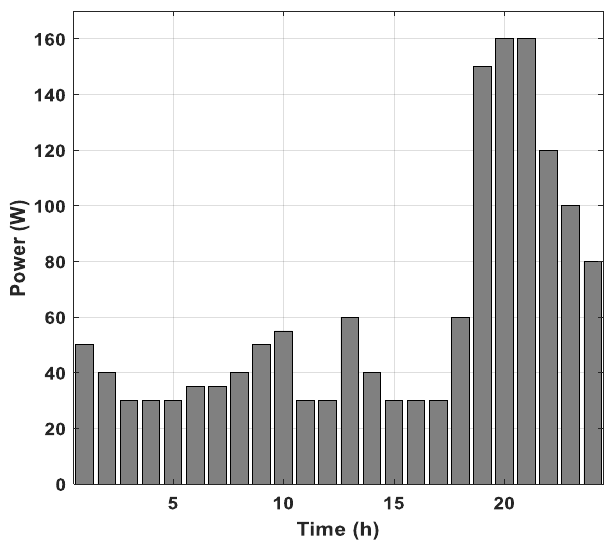
Figure 5. Daily load profile.